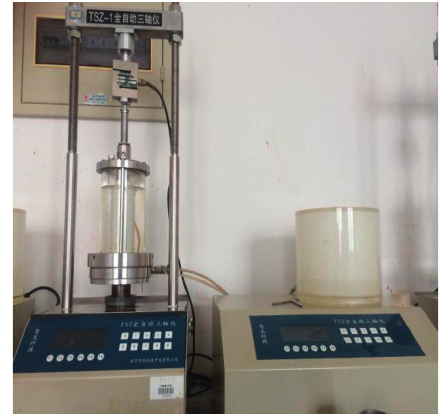
Figure 6: Photograph showing the triaxial apparatus.